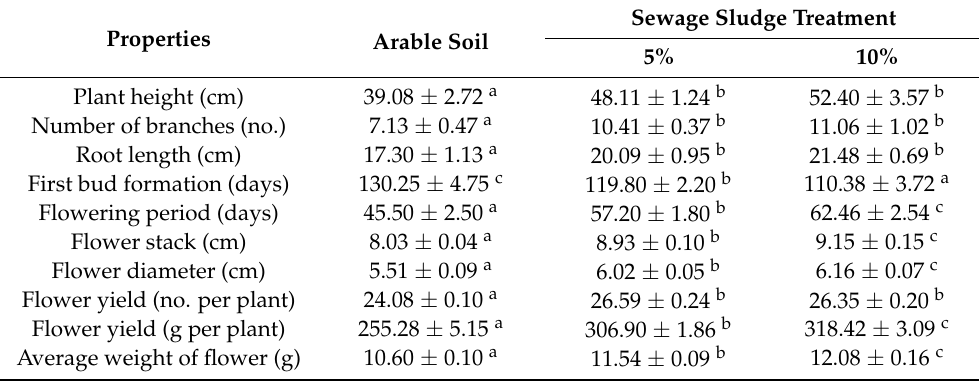
Table 2. Impact of sewage sludge amendment on growth, yield, and flower characteristics of cultivated